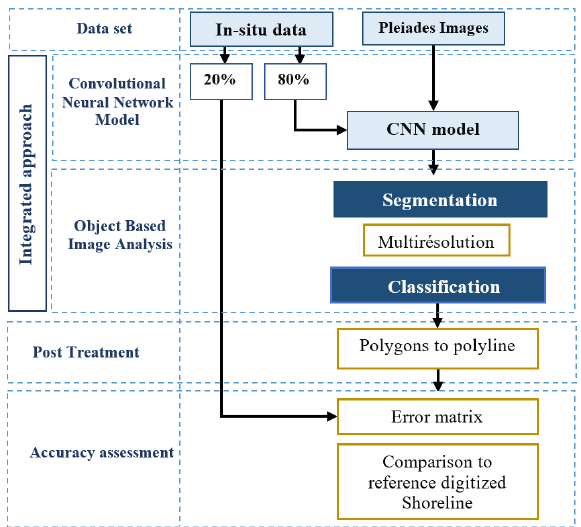
Figure 2. Methodology